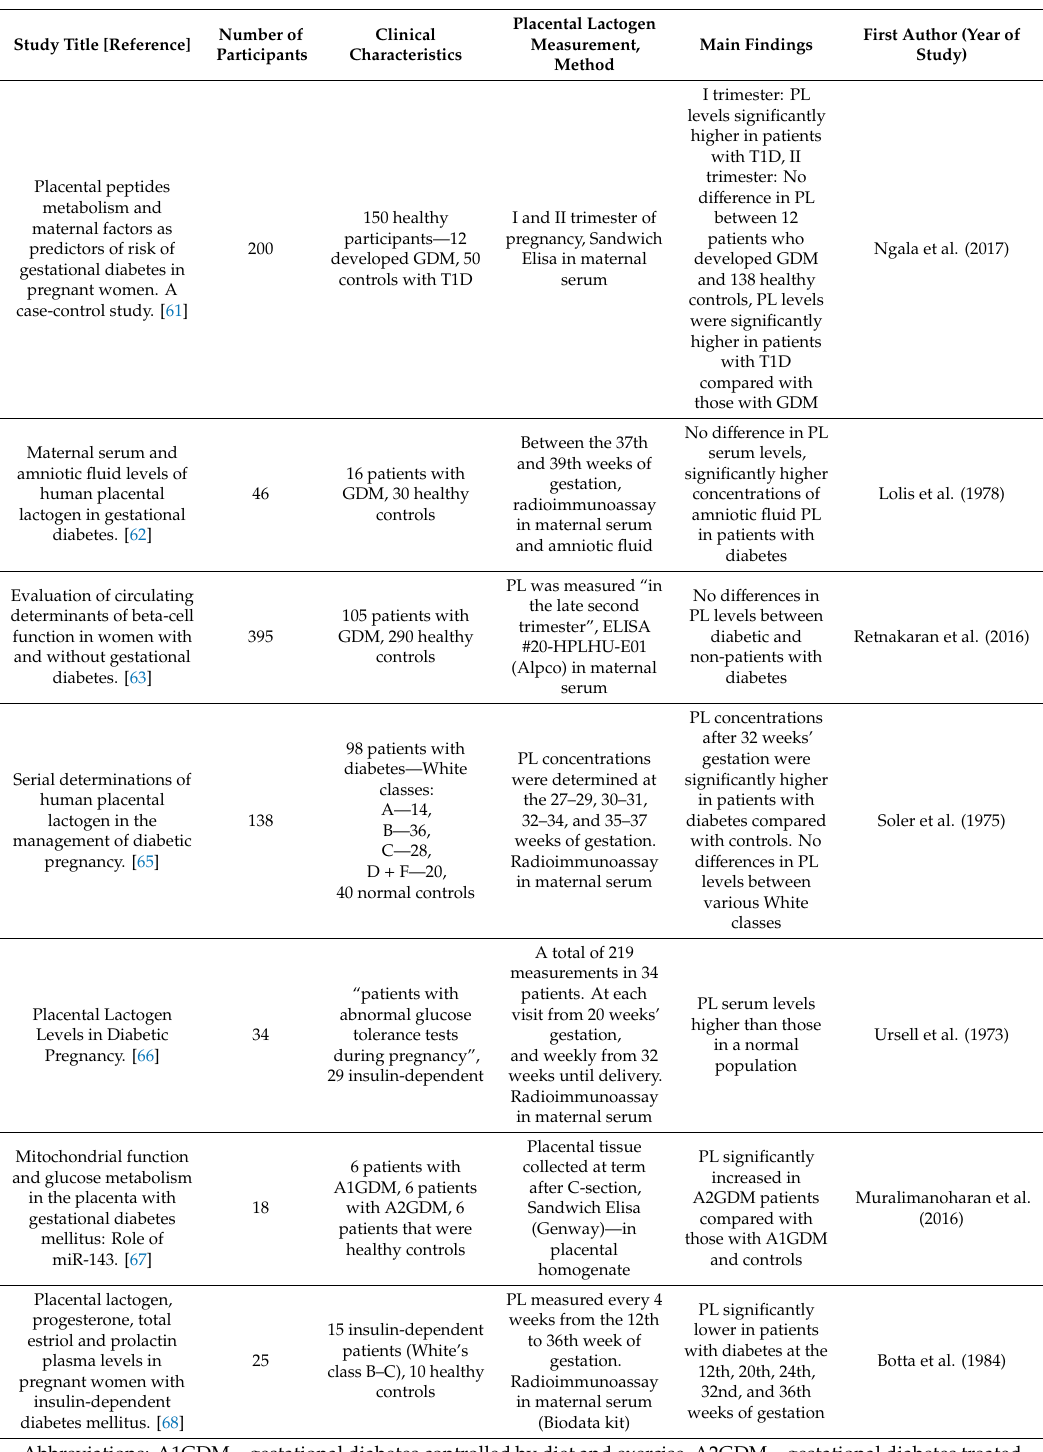
Table 1. Placental lactogen throughout diabetic